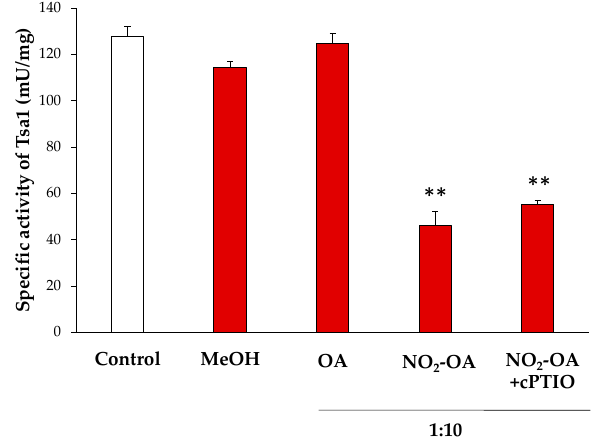
Figure 4. Effect of the NO 2 -OA treatment on the enzymatic activity of peroxiredoxin Tsa1. The specific activity (mU/mg prot) in presence of methanol (MeOH, the NO 2 -OA solvent), oleic acid (OA, the non-nitrated form of NO 2 -OA), and NO 2 -OA, both without and with the cPTIO pretreatment (NO scavenger), is shown. The concentration ratio was 1:10 (protein concentration: NO 2 -OA or OA). The results are the mean ± SEM of at least three independent experiments. Statistical significance between means were analyzed by Student’s t -test and double asterisk (**) indicates significant differences ( p < 0.001) from the control.